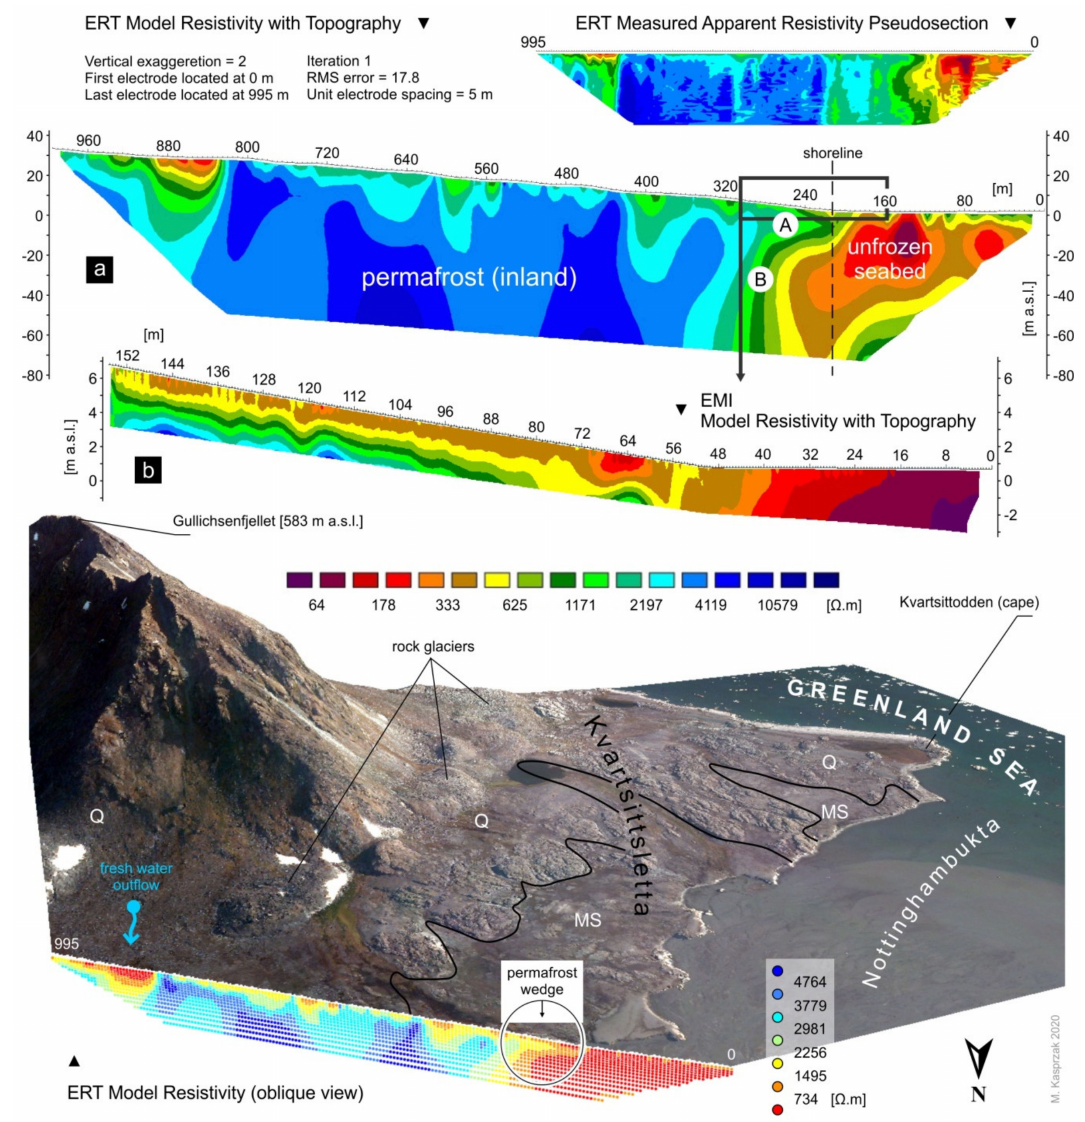
Figure 4. Results of the geophysical imaging of the coast (shoreface of Nottinghambukta and uplifted marine terraces of Kvartsittsletta): ( a ) electrical resistivity tomography (ERT), ( b ) electromagnetic induction (EMI), A —“permafrost wedge”, B —transition zone (permafrost-base active layer?), MS / Q—mica schists / quartzites according to the geological map [38]. Explanations in the